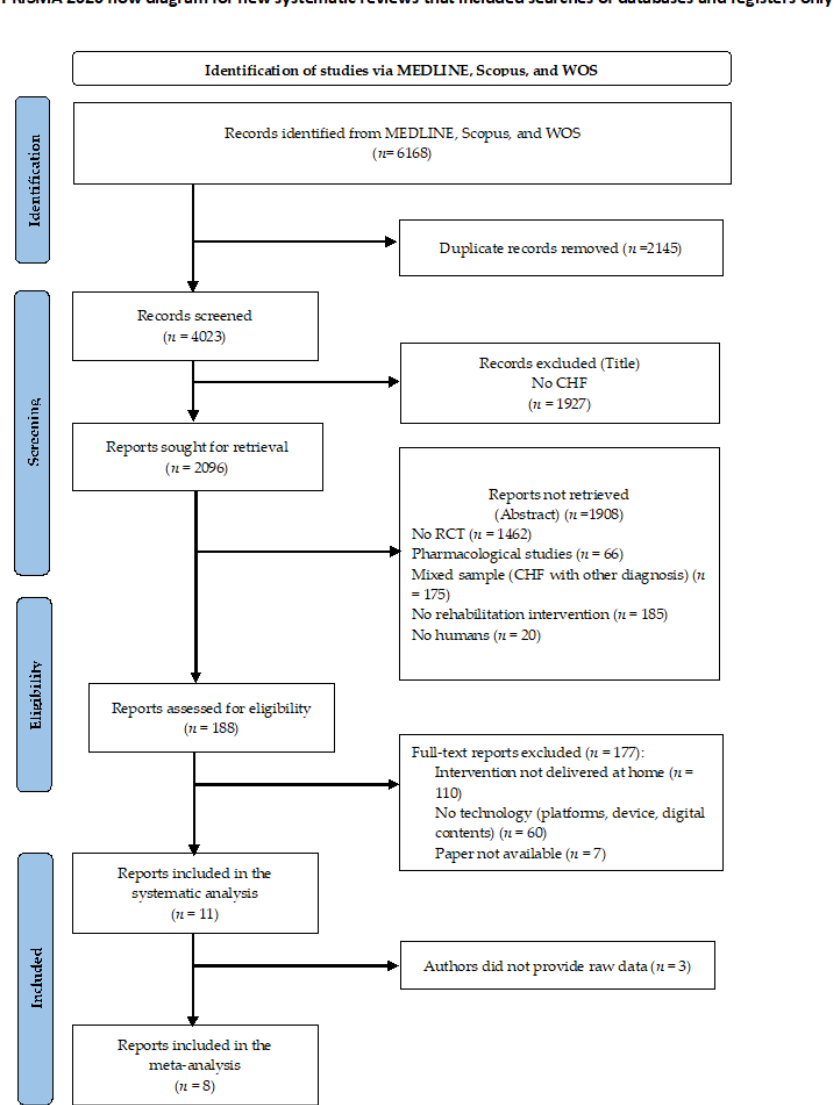
Figure 1. CONSORT Flow Diagram.